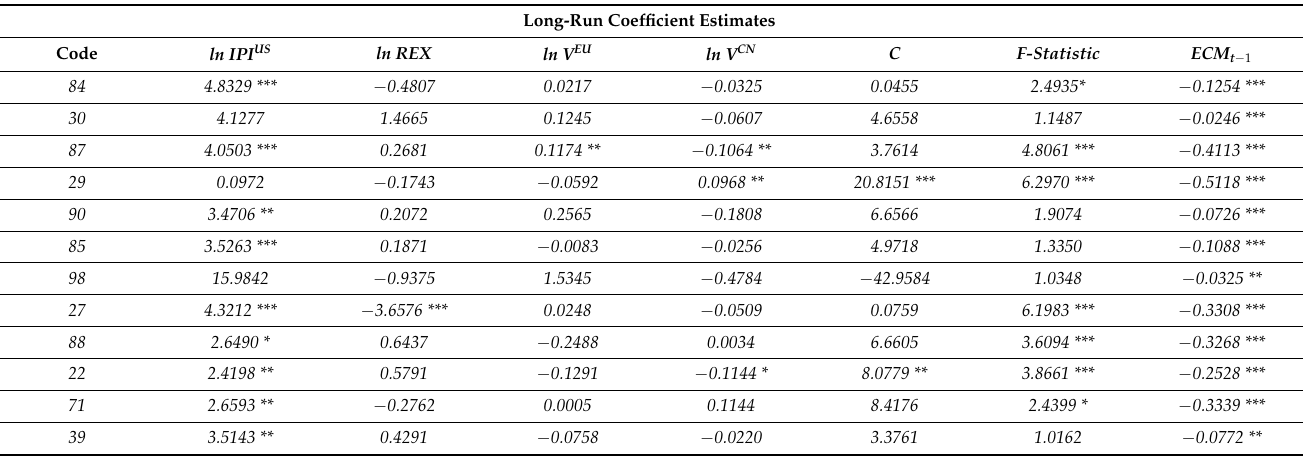
Table 6. Long-run coefficient estimates on US imports from the EU with third country effects using the linear ARDL model